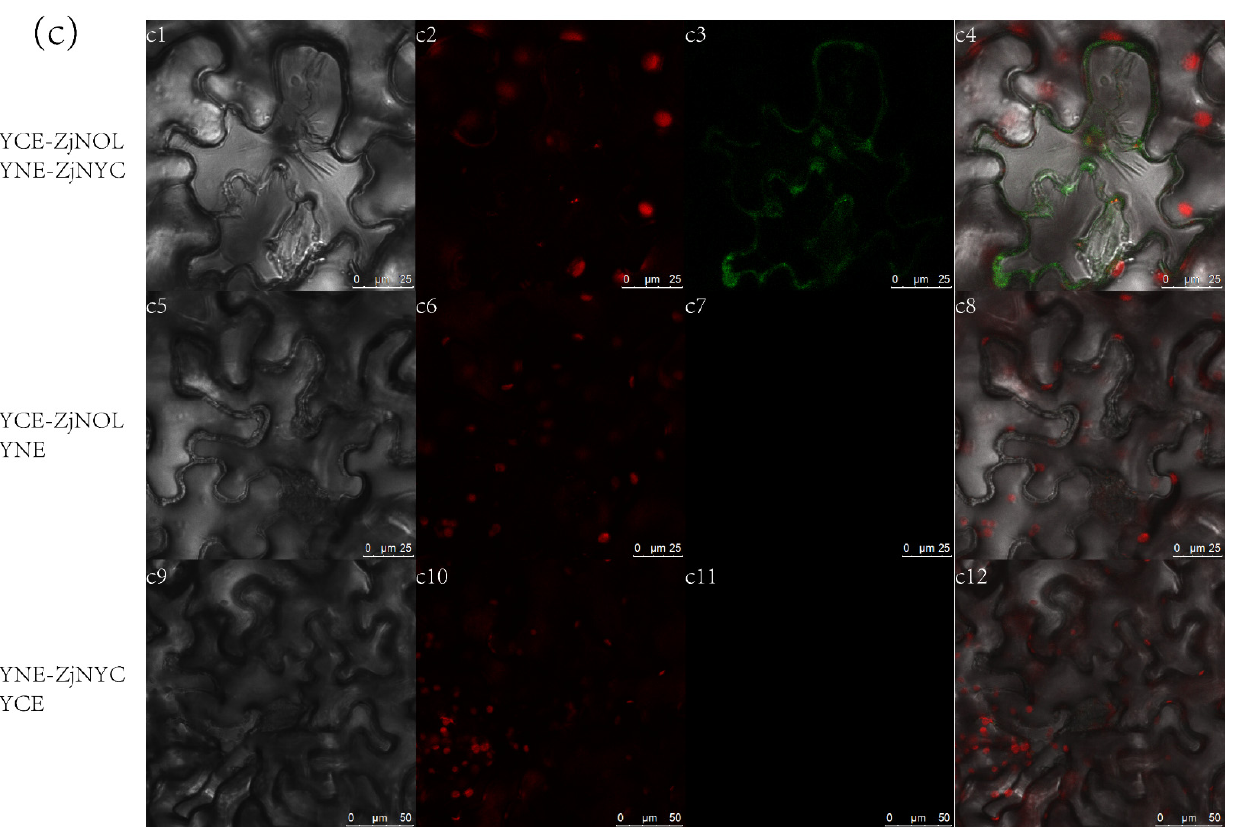
Figure 7. The interaction between ZjNOL and ZjNYC. ( a ) The binding mode of the complex ZjNYC with ZjNOL. ( a1 ), The backbone of protein was rendered in the tube and colored in blue (ZjNYC) and yellow (ZjNOL). ( a2 ), ZjNOL and ZjNYC proteins were rendered by the surface. ( a3 ), The detailed binding mode of ZjNOL with ZjNYC. Yellow dash represents hydrogen bond or salt bridge. ( b ) Interaction between ZjNOL and ZjNYC. By 10-fold repeated dilutions, yeast cells were identified on increasing stringency QDO/X/A agar plates. Positive clones were blue, whereas negative clones were white or missing. The negative control was pGBKT7-53 or pGADT7-T, while the positive control was pGBKT7-53 and pGADT7-T co-transformed. ( c ) The interaction between ZjNOL and ZjNYC in living cells showed by BiFC. ( c1 – c4 ), YCE-ZjNOL and YNE-ZjNYC fluorescent detection. ( c5 – c8 ), YCE-ZjNOL and YNE fluorescent detection. ( c9 – c12 ), YNE-ZjNYC and YCE fluorescent de- tection. ( c1 , c5 , c9 ), Bright light; ( c2 , c6 , c10 ), chlorophyll autofluorescence; ( c3 , c7 , c11 ), YFP fluorescence; ( c4 , c8 , c12 ), merged signal. Negative control was YCE-ZjNOL co-expression with YNE or YNE-ZjNYC co-expression with YCE.